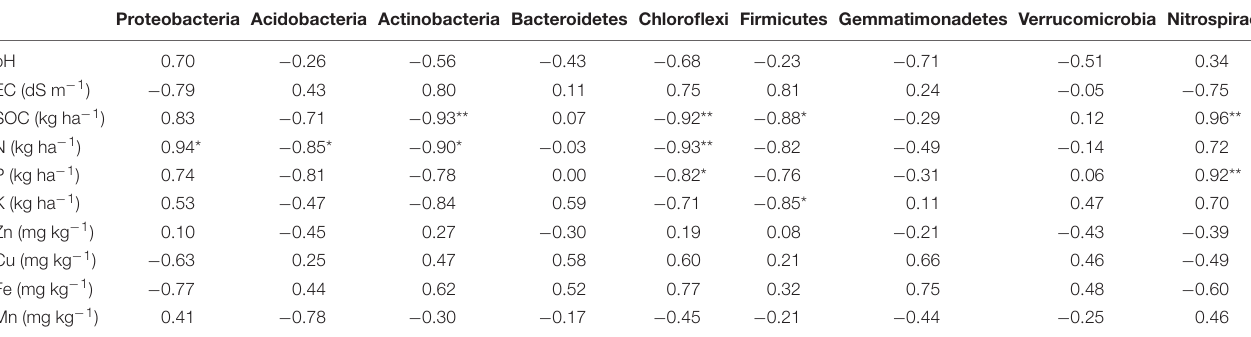
FIGURE 7 | Principal component analysis among the soil properties and dominating bacterial phyla of six agricultural management systems. TABLE 5 | Relationships between bacterial phyla and soil properties in six scenarios of agriculture